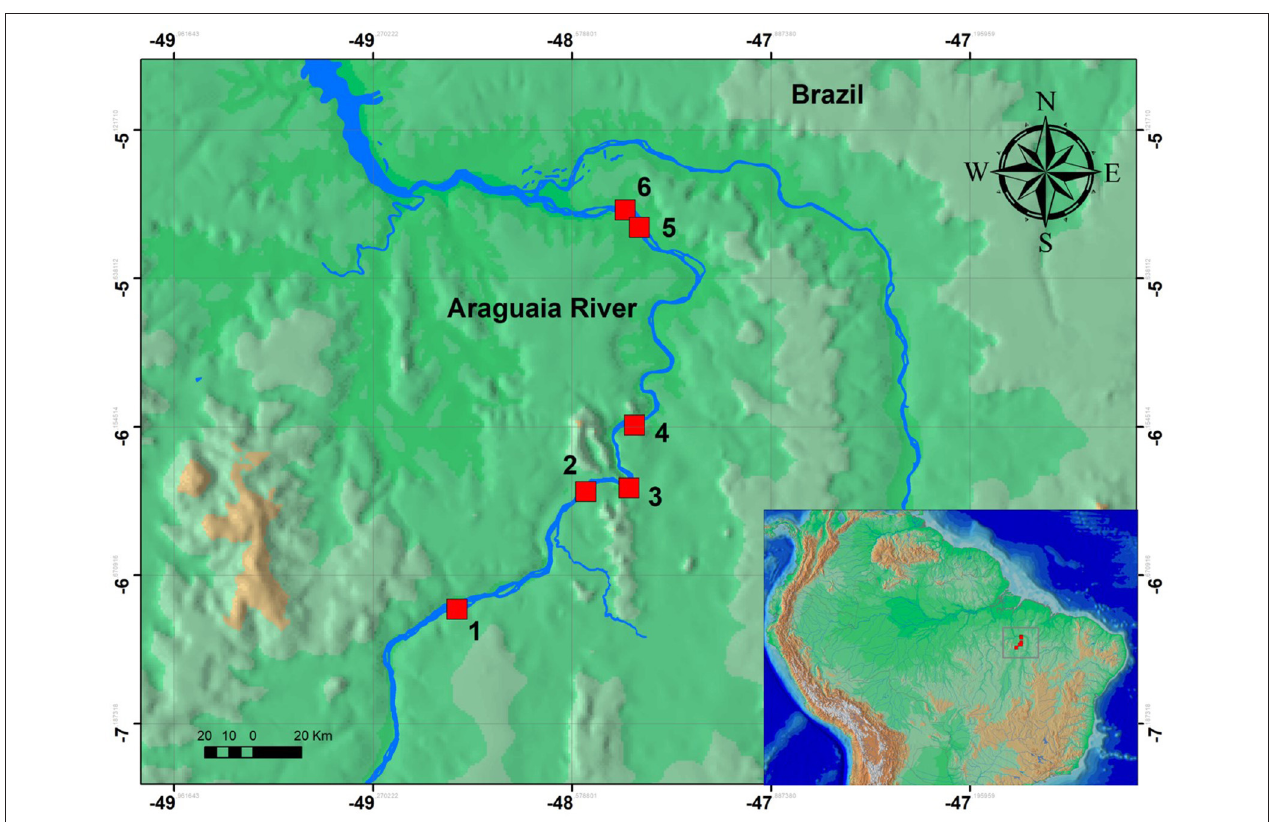
FIGURE 2 | Map of the six regions of rapids sampled in this study. Localities are: (1) Zé dos Gatos rapid; (2) São Miguel rapid; (3) Remanso dos Botos rapid; (4) Santa Isabel rapid; (5) São Bento rapid; (6) Rebojo rapid.